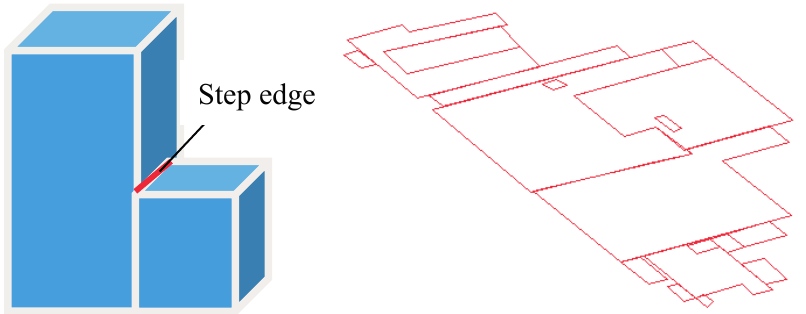
Figure 9. ( Left ) Step edge represented by red lines; ( Right ) After edge